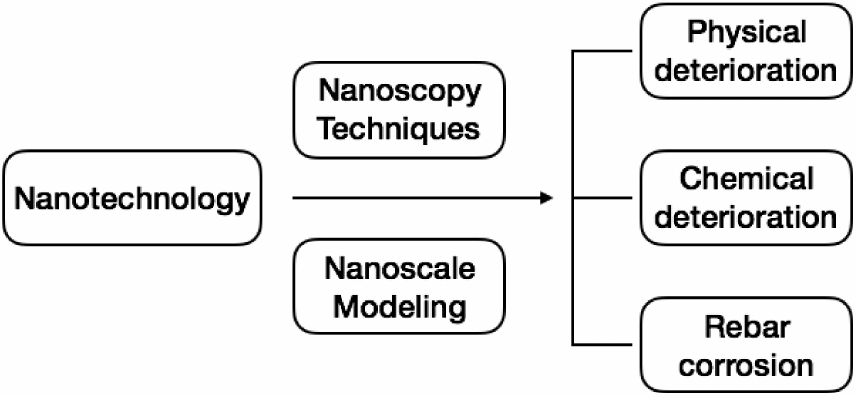
Figure 1. Overview of the sections in this review article, mainly based on the relevant papers published in the last